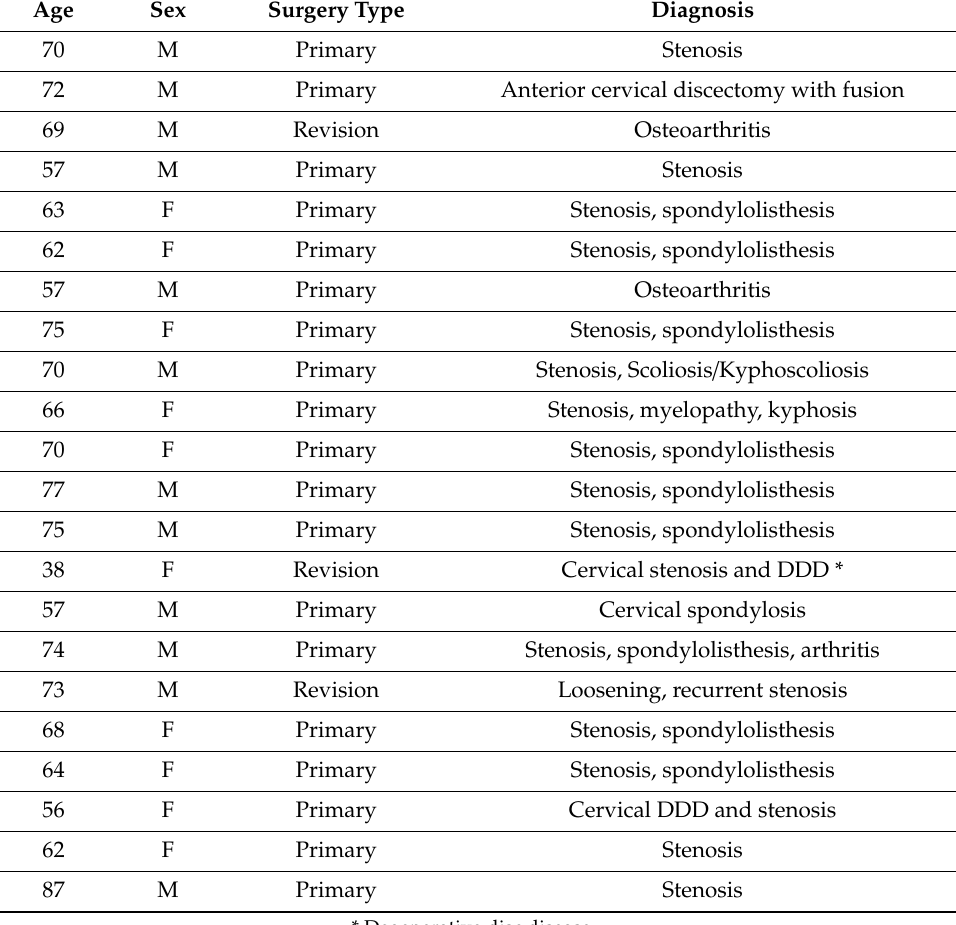
Table 2. Spinal procedure subjects.